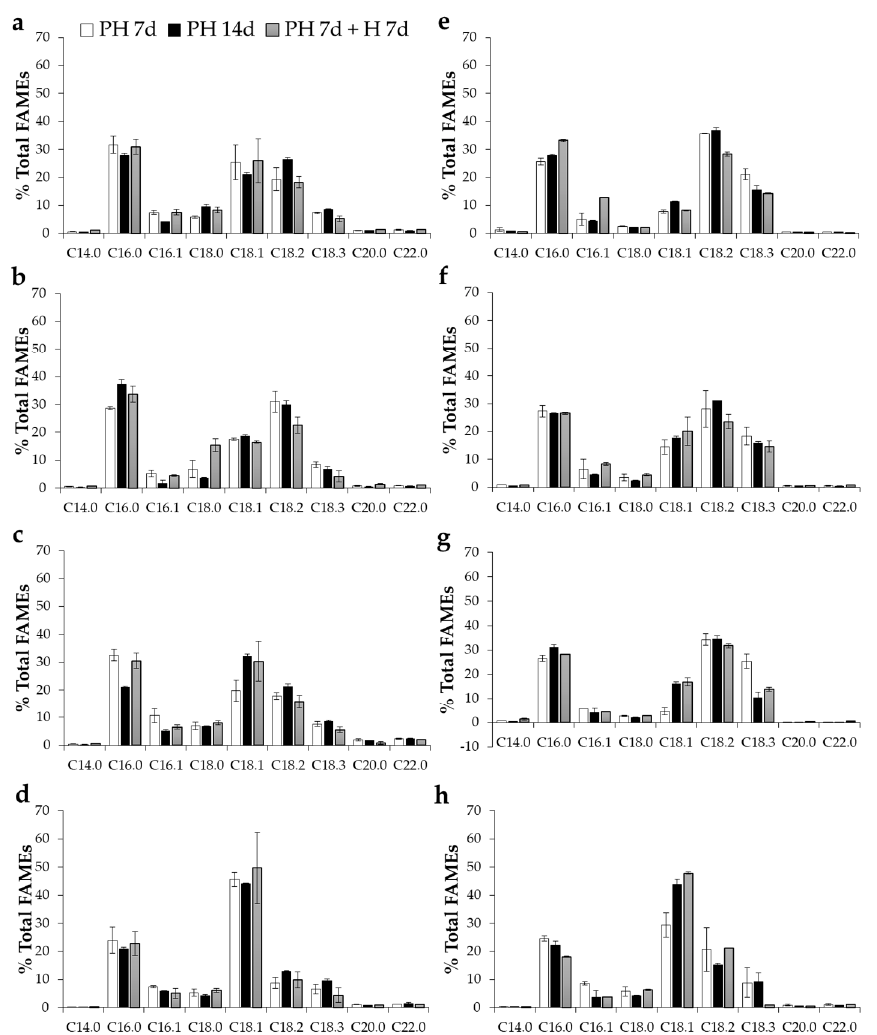
Figure 3. FAMEs composition (% total FAMEs) of C. sorokiniana , C. saccharophila , C. vulgaris, and Coelastrella sp. grown in birch hydrolysate and dairy effluent, either in the absence ( a , b , c , d ) or presence ( e , f , g , h ) of NPK. Cells were grown mixotrophic for 7 and 14 days (MT 7d and MT 14d), or first mixotrophic for 7 days, and then heterotrophic for another 7 days (MT 7d + H 7d). Error bars express the standard deviation of the mean ( n =